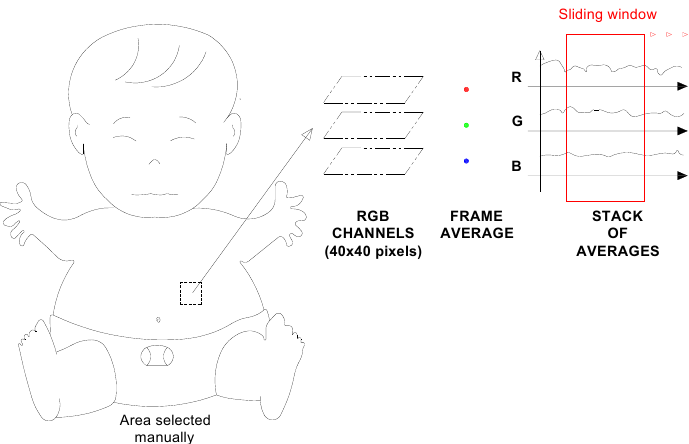
Figure 3. Illustration of processing: area selection, separation of RGB-channels, an average of each signal.